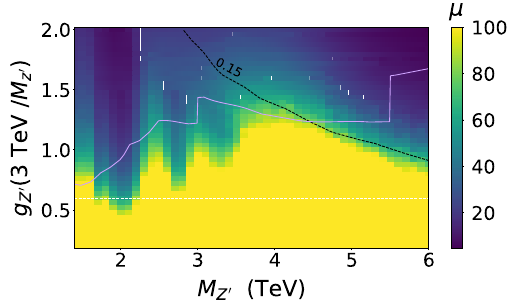
Fig. 11 μ for the 2 b -tag category of the ATLAS di-jet search [64] at each point in the scanned parameter space. The current search does not constrain the model. The dashed red line shows our estimate of the HL-LHC sensitivity. The solid purple line shows the combined observed bound from all LHC searches considered in this work. The dashed grey line shows the contour where (cid:10)/ M Z (cid:2) = 0 . 15 , and the region between the dashed white line and the bottom of the plot is favoured by the flavour and electroweak data at the 95% CL. Toward the extreme left-hand side of the plot, our predictions become more inaccurate due to / M 2 ) relative corrections unaccounted-for O ( M 2 Z Z (cid:2)